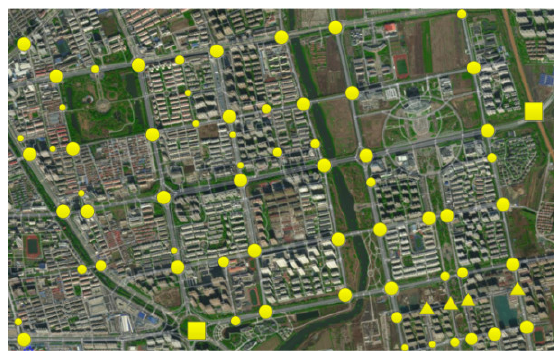
Figure 13. Location of real intersections in the area of the dataset.